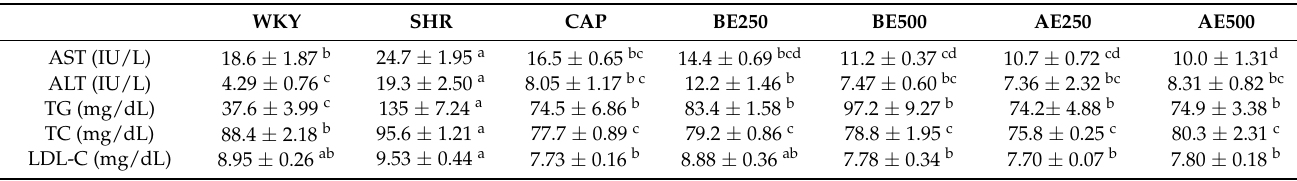
Table 2. Blood biochemical parameters in serum and plasma of the rats administered with black soybean or adzuki bean extracts for 8 weeks. AST: aspartate transaminase, ALT: alanine aminotransferase, TG: triglyceride, TC: total cholesterol, LDL-C: Low density lipoprotein